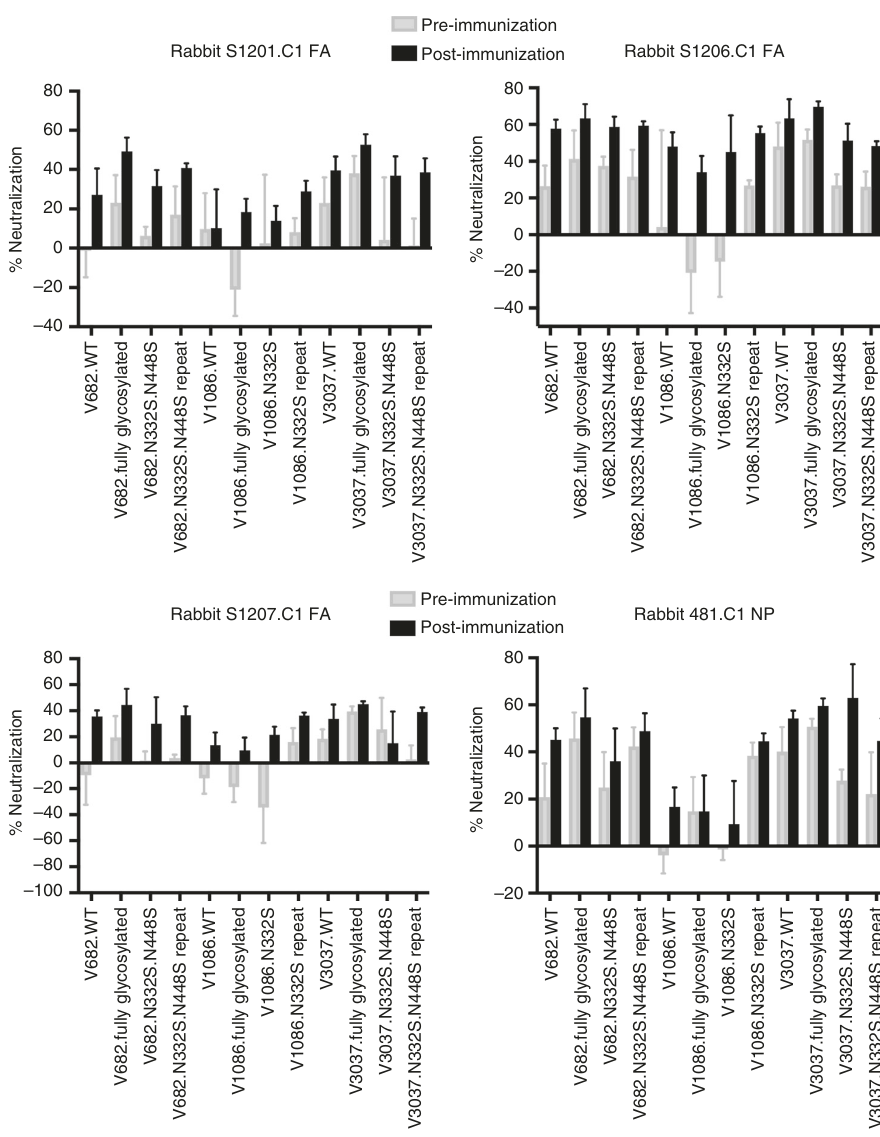
Fig. 4 Anti-CONE 1 rabbit sera have moderate inhibitory activity against pseudotyped HIV-1. Pre- and post-immunization sera were heat